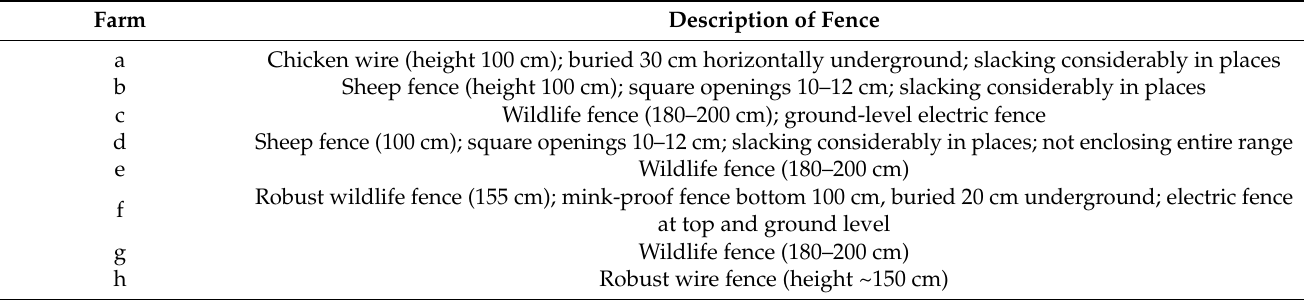
Table 7. Description of fences around free-range areas on organic broiler farms ( n = 8) in Sweden. Farm Description of